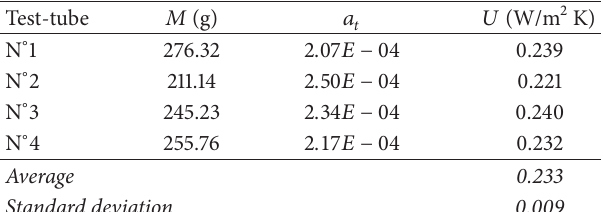
Table 1: Experimental values of the overall heat loss